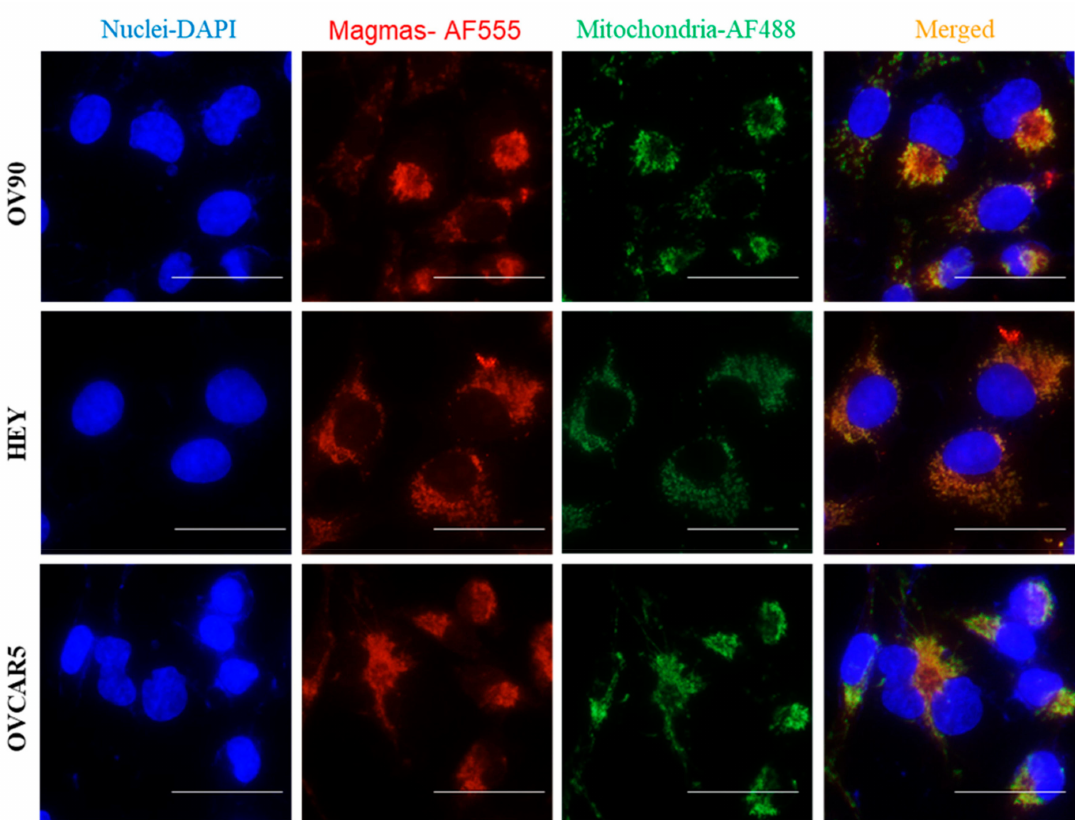
Figure 2. Co-localization of Magmas with the mitochondrial fluorescent dye marker AF488 in OV90, HEY and OVCAR5 human ovarian cancer cell lines. OV90, HEY and OVCAR5 cells were fixed with 4% paraformaldehyde, and probed with Magmas targeting primary antibody [83] and co-stained with mitochondria specific primary followed by respective secondary antibodies (AF555, AF488, Life Technologies). DAPI (4 (cid:48) ,6-diamidino-2-phenylindole) (Invitrogen, Carlsbad, USA) was used to stain cellular nuclei. Fluorescence imaging was performed using Leica EVOS FL Auto 2 microscope. Scale bar = 75 µ m, Magnification is 40 ×